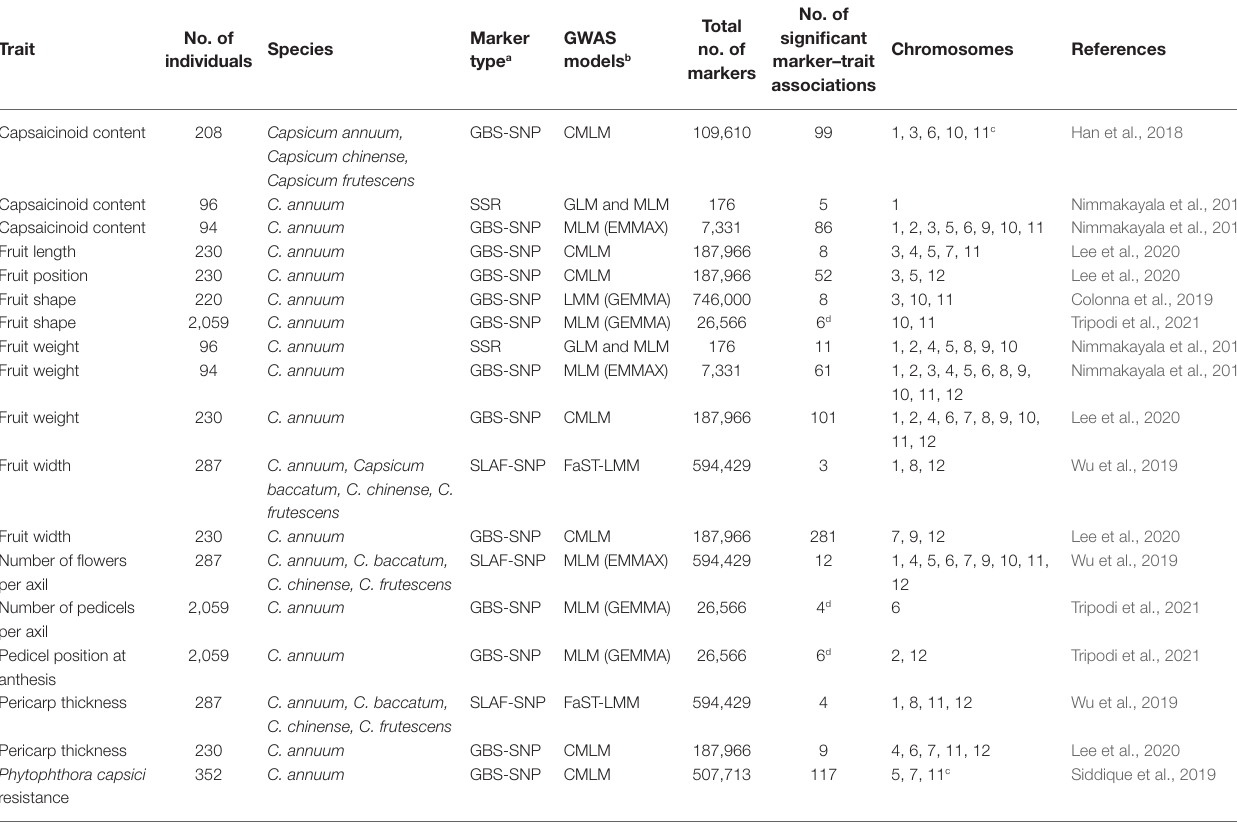
TABLE 1 | Summary of major genome-wide association studies (GWAS) conducted for different traits in chile pepper.